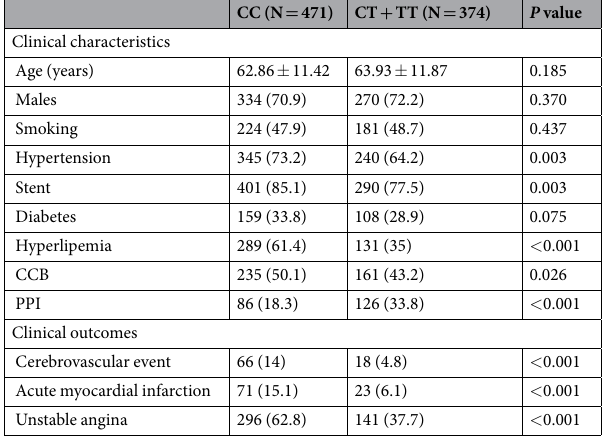
Table 2. Clinical characteristics in the CES1 S75N genotype groups in all subjects. Measure data are N (%), continuous data are mean ± standard deviation (SD), unless otherwise indicated.